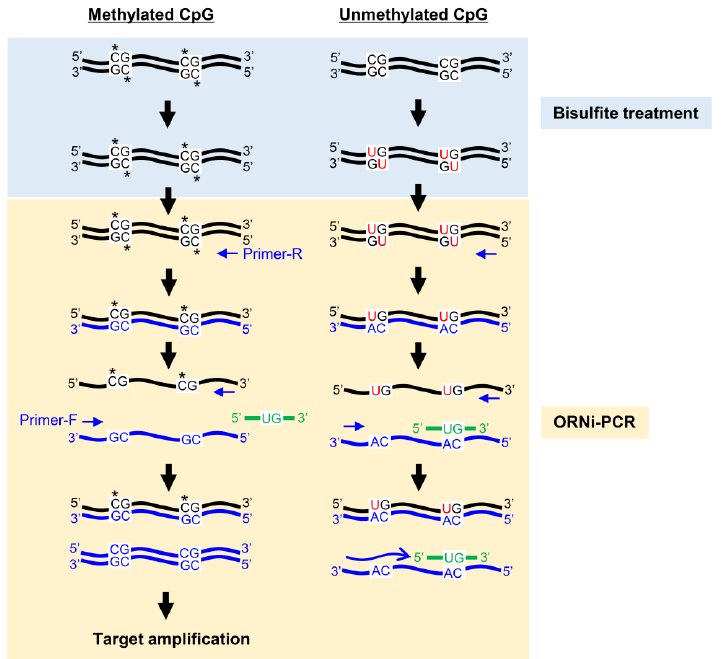
Figure 5. Schematic diagram of ORNi-PCR with bisulfite-treated DNA. Bisulfite-treated DNA is subjected to ORNi-PCR with an ORN corresponding to the converted target DNA sequence. In this scheme, an ORN (green line) targeting unmethylated CpG sites is hybridized with a corresponding DNA sequence synthesized in the first cycle of ORNi-PCR (blue line), which blocks target amplification.